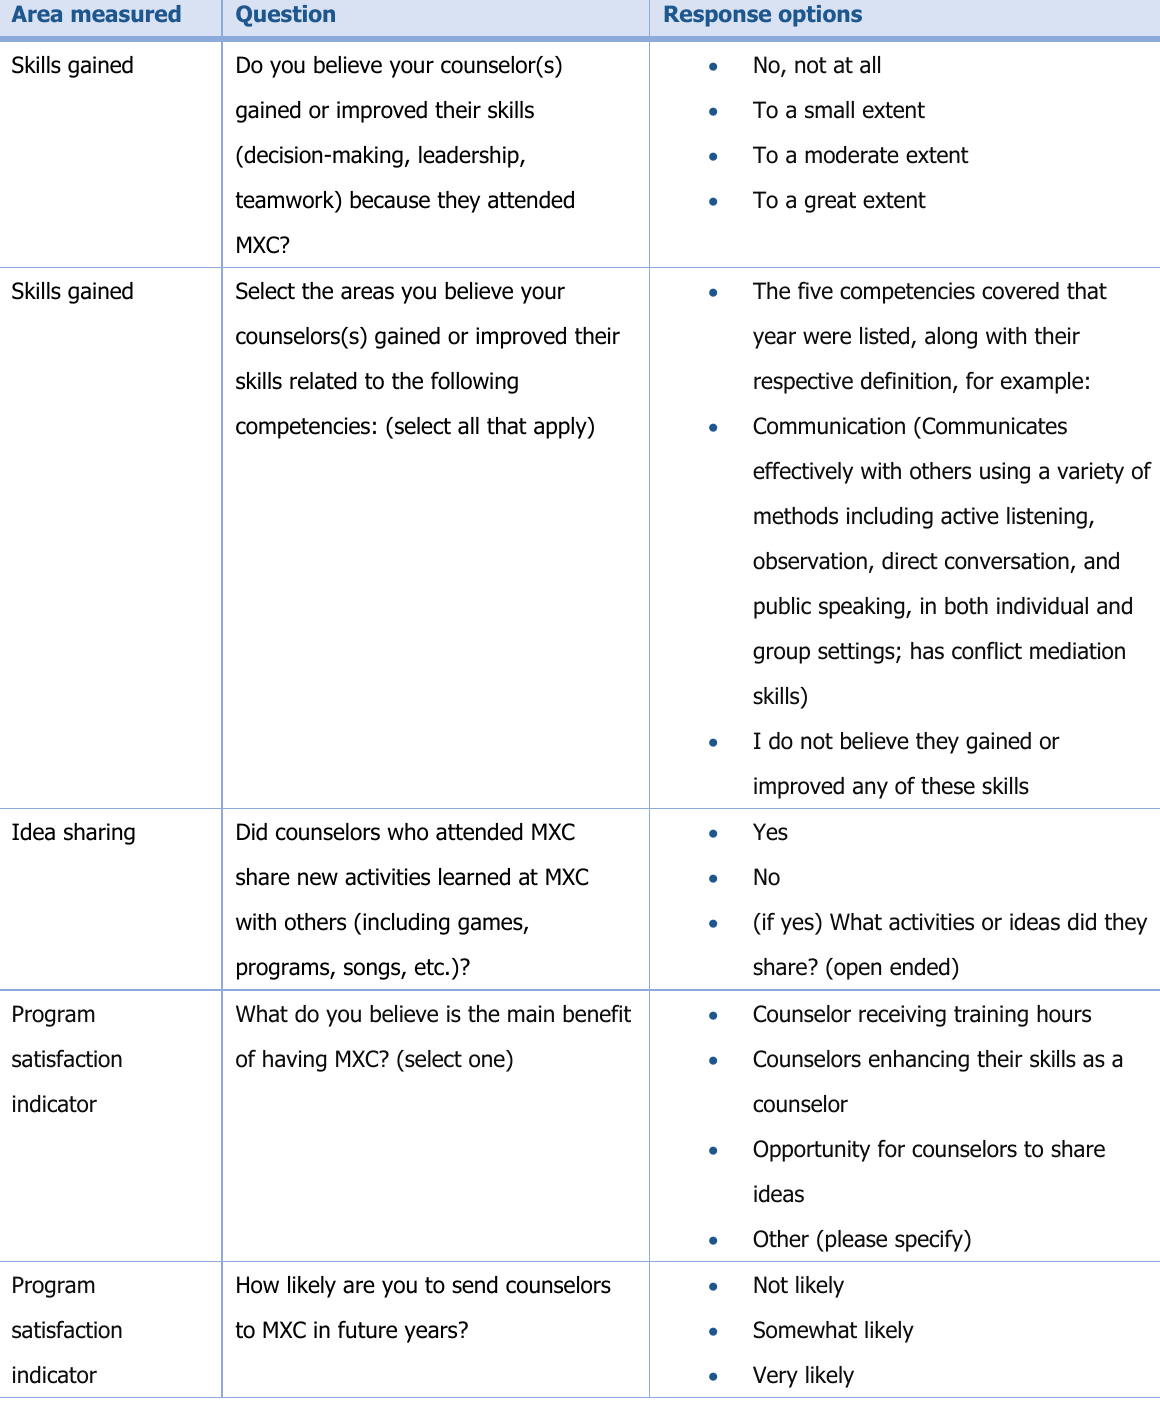
Table 6. Questions and Response Options for 4-H Professional Instrument Area